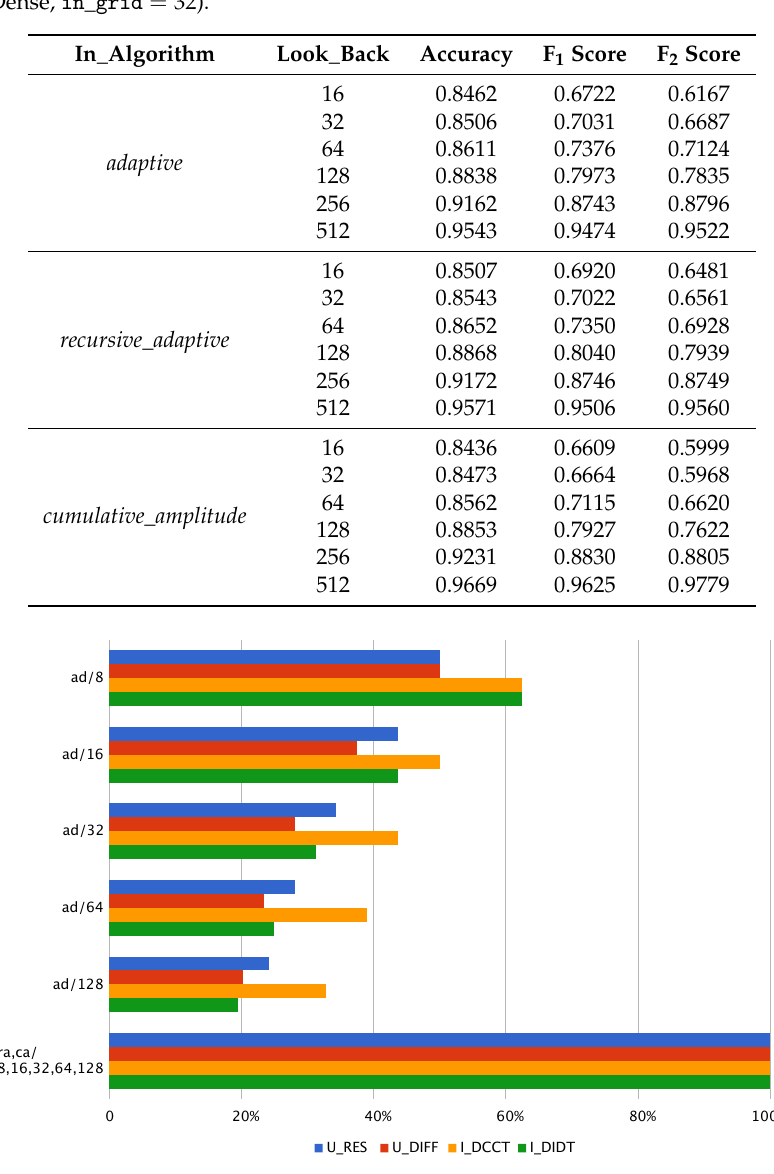
Table 1. The parameters of NN built with GRU cells for three different algorithms (two layers, 64 and 32 cells + Dense, in _ grid = 32).